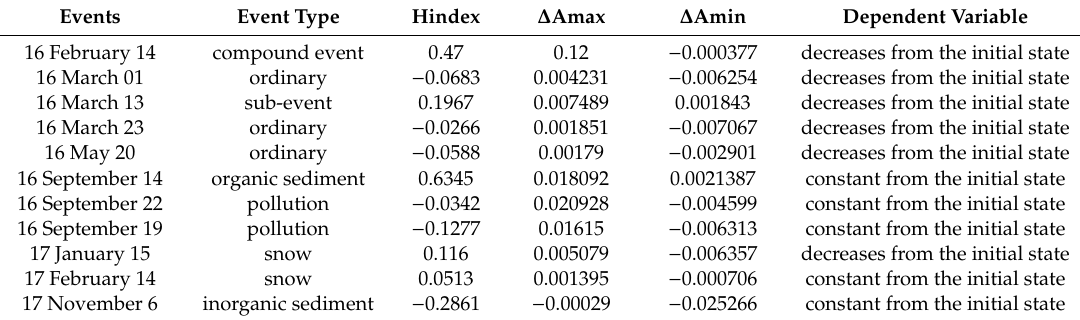
Table 4. Hysteretic index